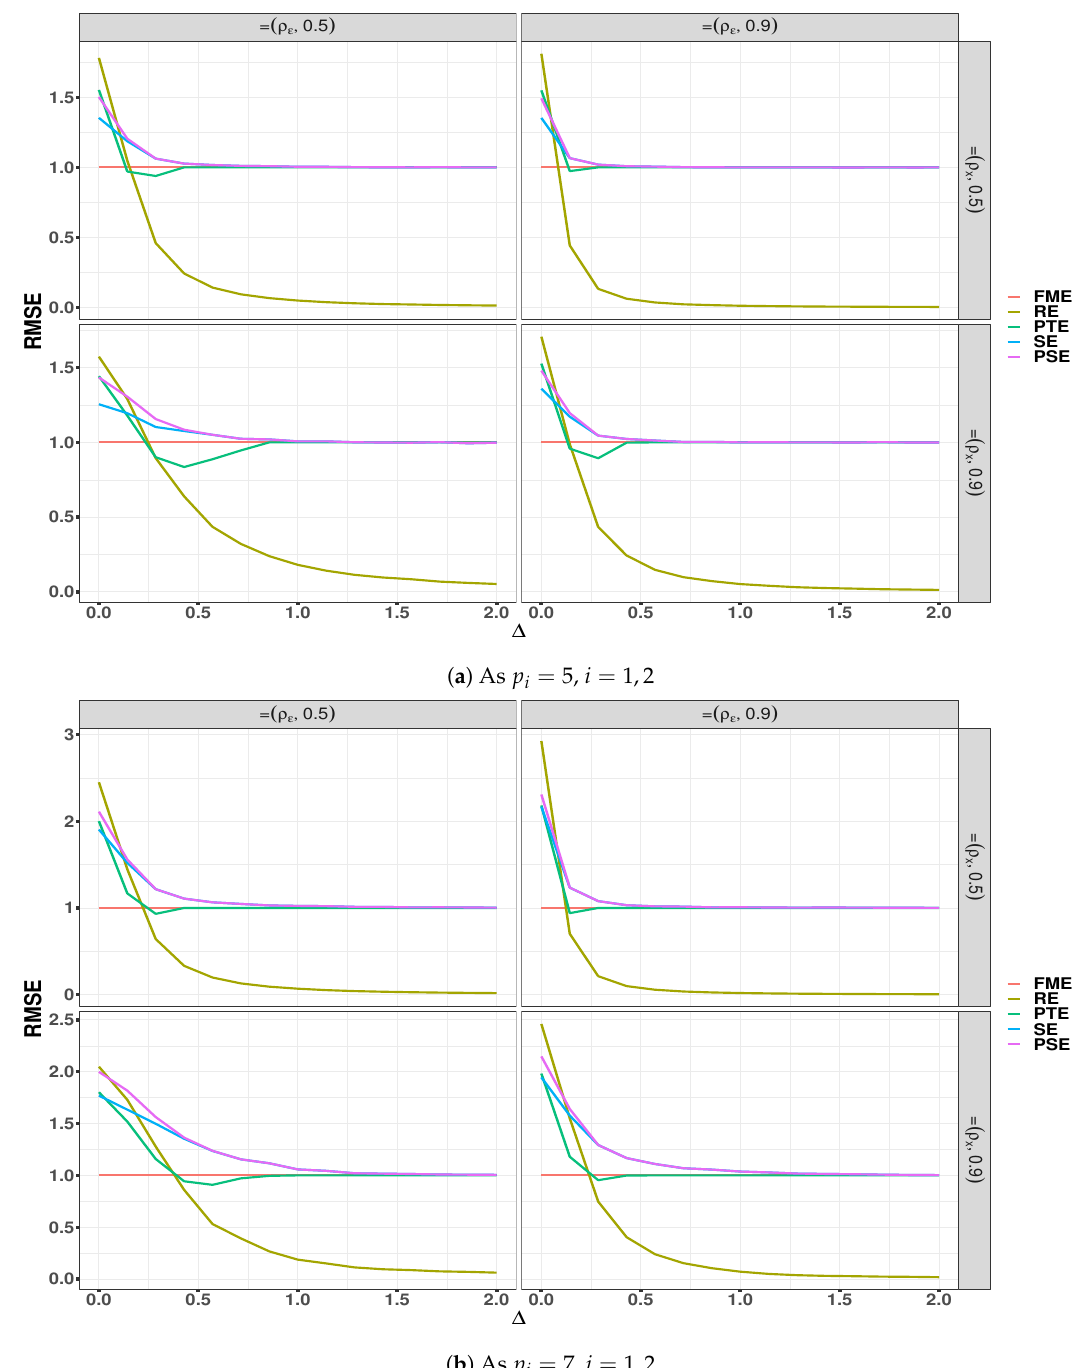
Figure 2. RMSE of the estimators as a function of ∆ when M = 3, T = 100, ρ x = 0.5,0.9, and ρ ε =